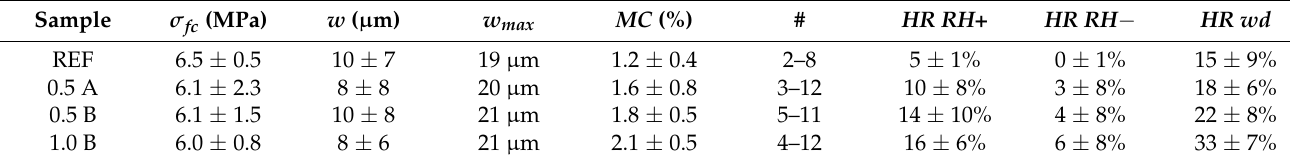
Table 1. First cracking strength σ fc (MPa), average crack width at 1% strain w (µm), maximal crack width at 1% strain w max (µm), flexural strain-hardening amount as a measure for multiple cracking at full flexural strain-hardening MC (%), number of cracks at full flexural strain-hardening # (-),healing ratio HR at high RH+ , standard RH − , and wet/dry cycling wd (%).